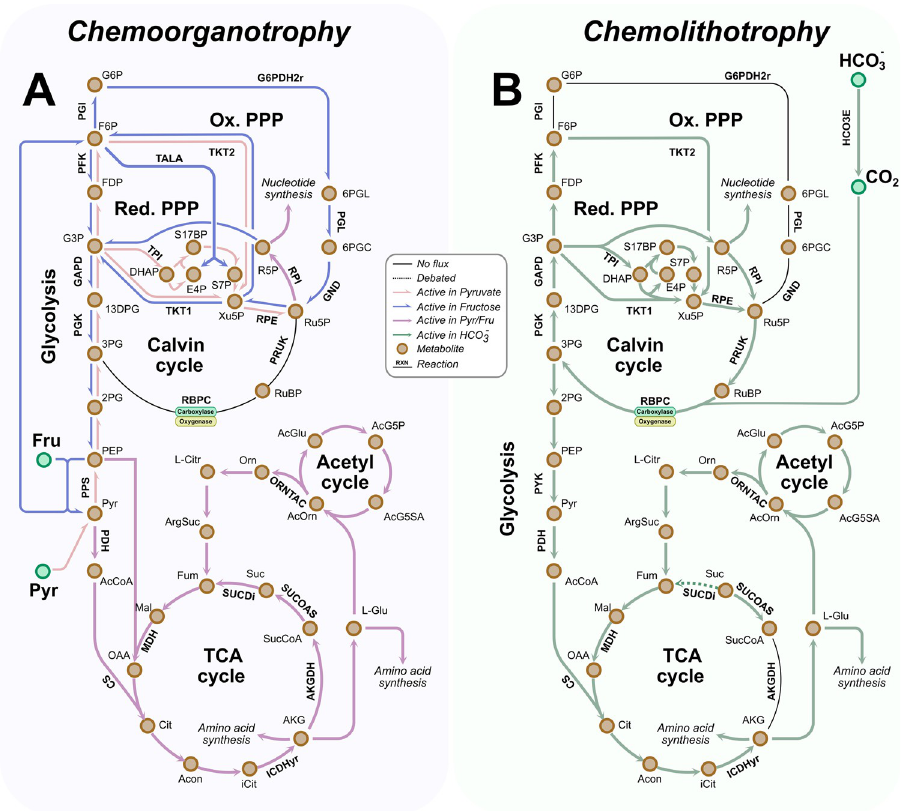
Fig 2. Map of the metabolic flux distributions predicted under chemolithoorganotrophic and chemolithotrophic conditions. The map shows the changes in the flux distributions under four different growth conditions. Ammonium is present under all conditions but changing the carbon source (fructose, pyruvate, and HCO 3- ). (A) Chemolithoorganotrophy metabolism. The fructose uptake rate was constrained to 0.746 mmol/gDW/h, and the ammonium uptake rate was 0.5mmol/gDW/h. (B) Chemolithotrophy metabolism. HCO 3- uptake rates were constrained to 4.35 mmol/gDW/h for high and 1.43 mmol/gDW/h for low. Abbreviations: HCO3E, carbonic anhydrase; PYK, pyruvate kinase; PPS, phosphoenolpyruvate synthasePGK, phosphoglycerate kinase; GAPD, glyceraldehyde 3-phosphate dehydrogenase; PFK, phosphofructokinase; PGI, glucose 6-phosphate isomerase; G6PDH2r, glucose 6-phosphate dehydrogenase; PGL, 6-phosphogluconolactonase; GND, phosphogluconate dehydrogenase; RPI, ribose-5-phosphate isomerase; RPE, ribulose 5-phosphate 3-epimerase; TKT, transketolase; TPI, triose-phosphate isomerase; PRUK, phosphoribulokinase; RBPC, ribulose 1,5-bisphosphate carboxylase-oxygenase; PDH, pyruvate dehydrogenase; CS, citrate synthase; MDH, malate dehydrogenase; SUCDi, succinate dehydrogenase; SUCOAS, succinyl-CoA synthetase; AKGDH, 2-oxoglutarate dehydrogenase; ICDHyr, isocitrate dehydrogenase; ORNTAC, ornithine transacetylase; G6P, D-Glucose 6-phosphate; F6P, D-Fructose 6-phosphate; FDP,